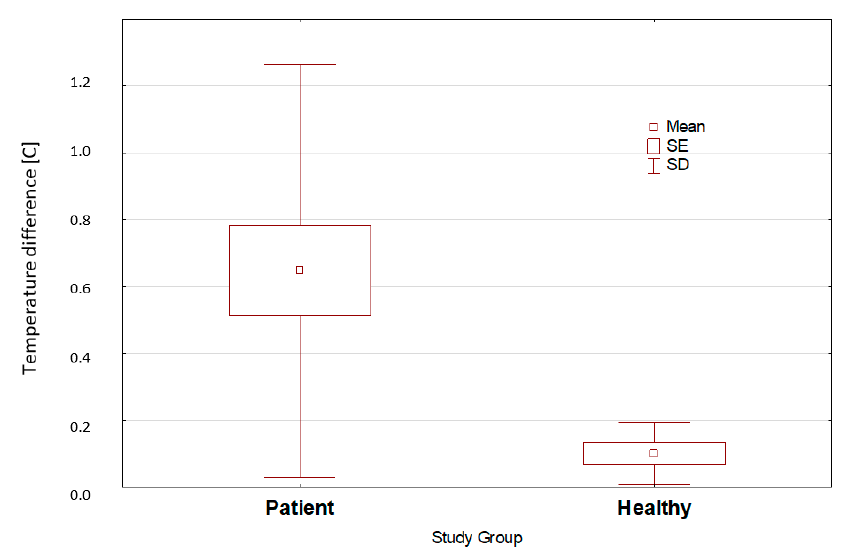
Figure 4. Box-and-whisker plot—absolute values of the mean periapical temperature differences in the suspect and contralateral teeth of the study and control group at 30 s of mouth opening.